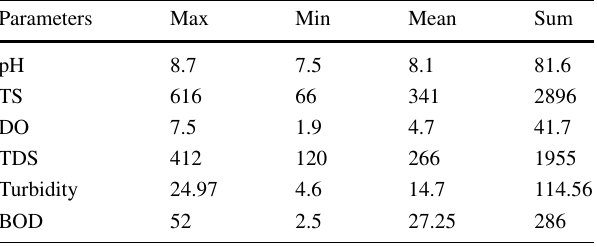
Table 5 Statistical summary of physico-chemical parameters